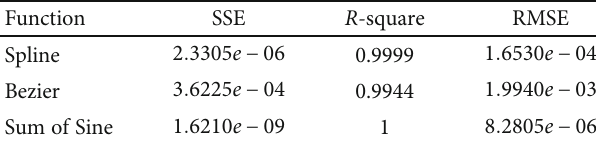
Figure 2: Design work fl ow of hybrid airfoil design Table 1: Fitting errors for di ff erent methods.